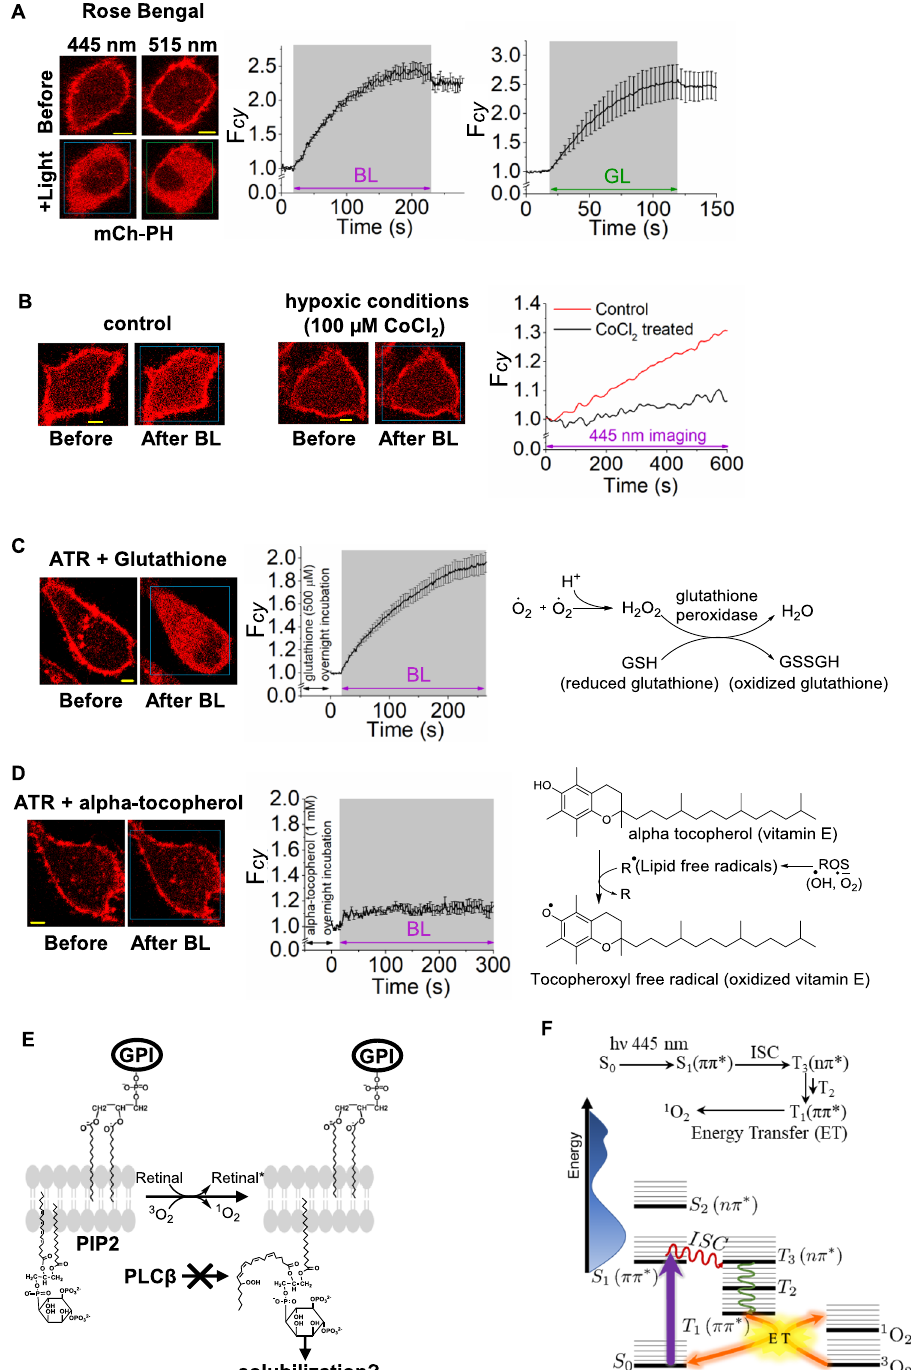
Figure 8. Comparison of PIP2 sensor dissociation from PM by retinal vs a known photosensitizer, rose bengal. ( A ) Images of HeLa cells expressing PIP2 sensor (mCherry-PH). ( A ) PIP2 sensor translocation was induced by rose bengal (50 µ M), incubated with cells for 5 minutes, in the presence of blue (4.86 µ W of 445 nm) and green (light (0.22 µ W of 515 nm) respectively. Plot shows the cytosolic fluorescence of PIP2 sensor in HeLa cells upon exposing to light. (mean ± S.E.M., n = 6). ( B ) HeLa cells were incubated with CoCl 2 (100 µ M) for 24 h to expose cells to hypoxia. The control cells were kept in same conditions without CoCl 2 treatment. Cells were incubated with ATR (50 µ M) and 445 nm imaging for 10 minutes was performed. Cell in hypoxic condition did not exhibit detectable PIP2 sensor accumulation in cytosol while control cells showed a gradual PIP2 sensor accumulation from PM to cytosol. ( C , D ) Antioxidants were tested to examine if they prevent PIP2 sensor translocation induced by retinal and blue light. HeLa cells expressing PIP2 sensor were incubated with antioxidants, alpha- tocopherol (1 mM) and reduced-glutathione ethyl ester (500 µ M) overnight. Prior to imaging experiments ATR (50 µ M) was added and incubated for 5 minutes followed by exposure of blue light (4.86 µ W of 445